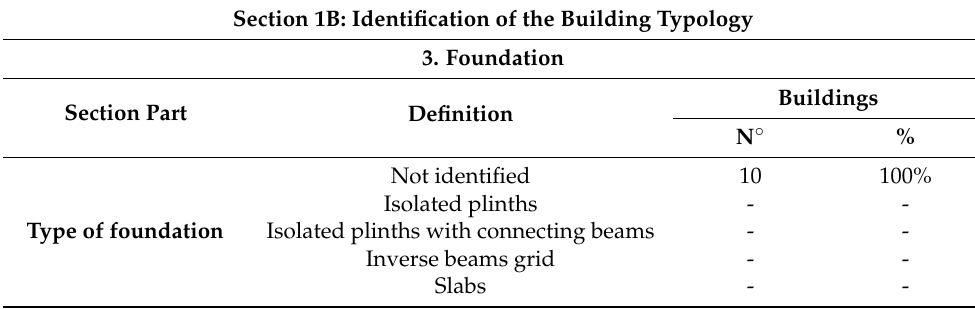
Table 7. Section 1B CARTIS-Building. Case studies characterization: 3. Foundation—Synoptic panel. Section 1B: Identification of the Building